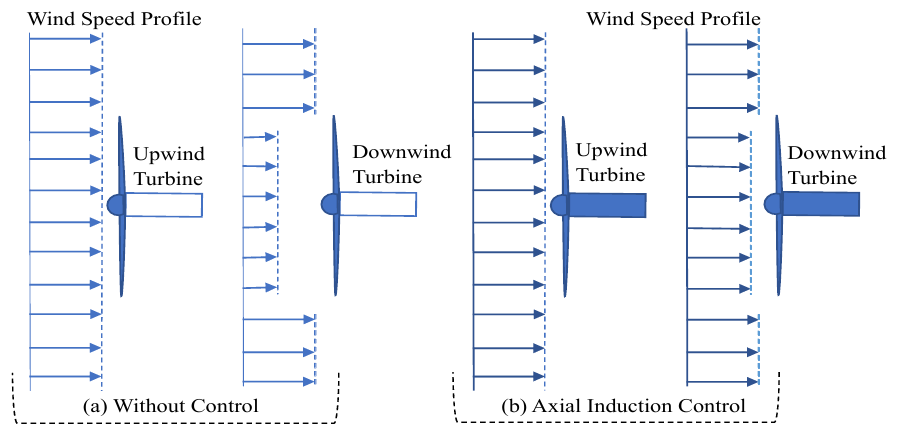
Figure 10. Schematic representation of axial induction control strategy.